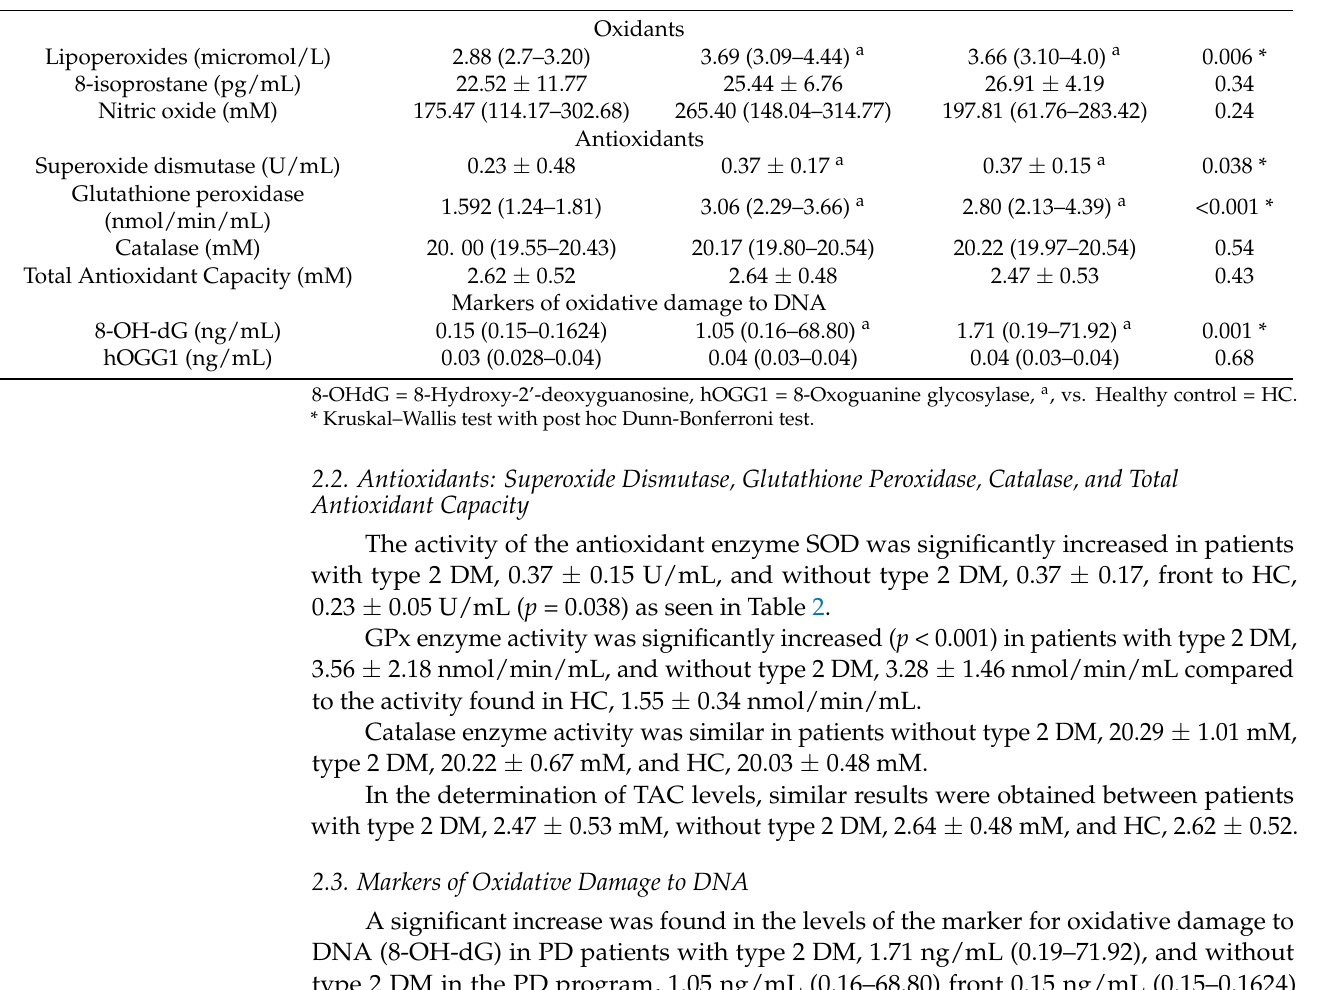
Table 2. Oxidants and antioxidants in patients in PD with and without type 2 DM vs. healthy controls. Healthy